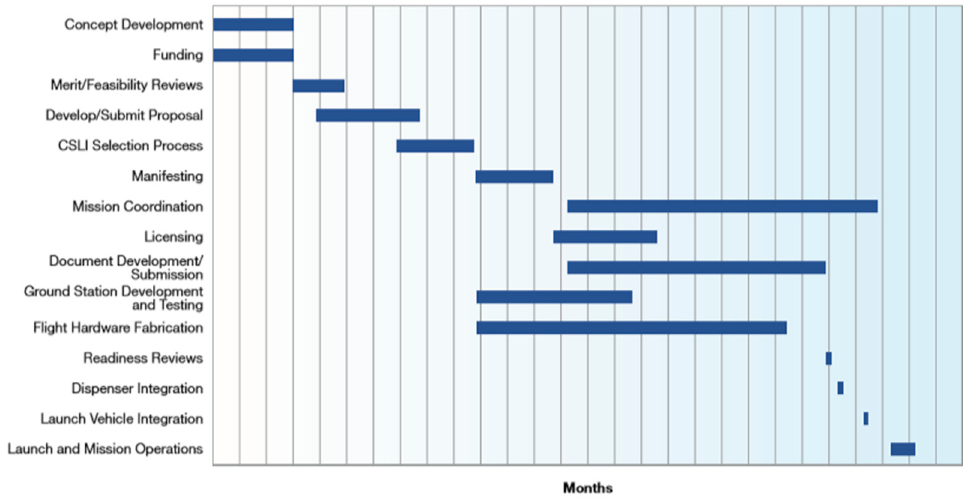
Figure 8. A timeline of a CubeSat project’s phases [13].